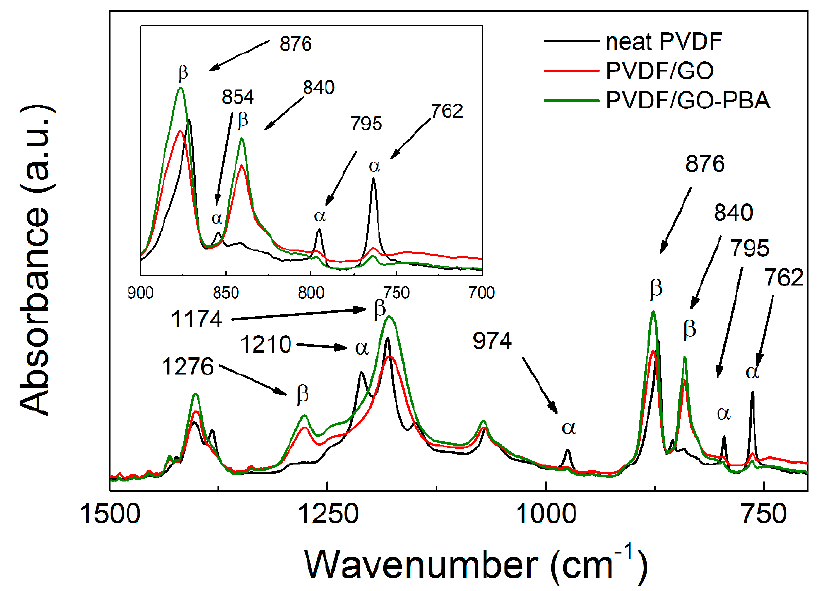
Figure 8. FTIR spectra of the neat PVDF and composites containing PVDF/GO and PVDF/GO-PBA particles.